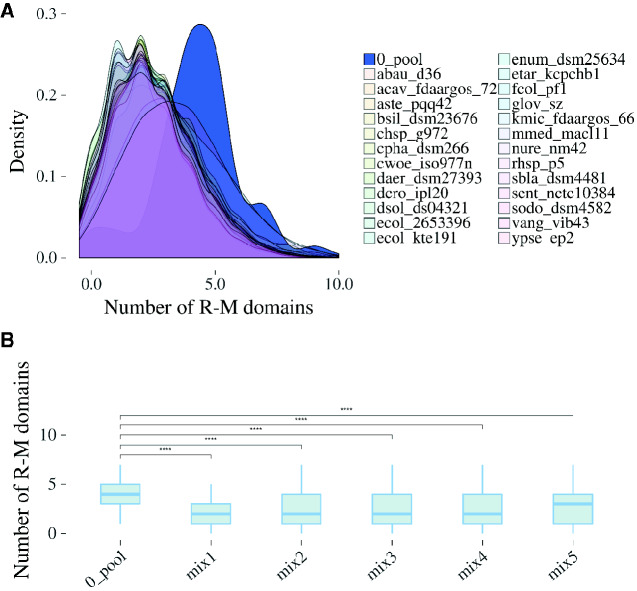
Distribution of R–M-related domains encoded in RR-like gene neighborhoods. (A) The density plot compares the distribution of genes encoding R–M domains found in close proximity to RR-like genes between the data set representing 628 actual bacterial genomes (0_pool) and the respective 2000 shuffled versions (pseudogenomes) of 25 different genomes gleaned from the 0_pool. Species and strain names are abbreviated as follows: Acinetobacter baumannii (abau_d36), Aeromonas caviae (acav_fdaargos_72), Alteromonas stellipolaris (aste_pqq42), Brevibacterium siliguriense (bsil_dsm23676), Chryseobacterium sp. G972 (chsp_g972), Chlorobium phaeobacteroides (cpha_dsm266), Conexibacter woesei (cwoe_iso977n), Diaminobutyricimonas aerilata (daer_dsm27393), Devosia crocina (dcro_ipl20), Dickeya solani (dsol_ds04321), Escherichia coli (ecol_2653396), Escherichia coli KTE191 (ecol_kte191), Endozoicomonas numazuensis (enum_dsm25634), Edwardsiella tarda (etar_kcpchb1), Flavobacterium columnare (fcol_pf1), Geobacter lovleyi (glov_sz), Klebsiella michiganensis (kmic_fdaargos_66), Martelella mediterranea (mmed_macl11), Nitrosomonas ureae (nure_nm42), Rhodovulum sp. P5 (rhsp_p5), Shimwellia blattae (sbla_dsm4481), Salmonella enterica subsp. enterica serovar Senftenberg (sent_nctc10384), Serratia odorifera (sodo_dsm4582), Vibrio anguillarum (vang_vib43), Yersinia pseudotuberculosis (ypse_ep2). (B) The box plots depict the statistical analysis using one-tailed Student’s t-test between the 0_pool and five compilations (“mix”) of the 25 pseudogenomes previously simulated. Each mix contains five strains. t-Test results are represented as follows: ns (P > 0.05), * (P ≤ 0.05), ** (P ≤ 0.01), *** (P ≤ 0.001), **** (P ≤ 0.0001). The mix data sets include the following above mentioned genomes: mix1—abau_d36, acav_fdaargos, aste_pqq42, bsil_dsm23676, chsp_g972; mix2—cwoe_iso977n, dear_dsm27393, dcro_ipl20, dsol_ds04321, ecol_2653396; mix3—ecol_kte191, enum_dsm25634, etar_kcpchb1, fcol_pf1, glov_sz; mix4—kmic_fdaargos, mmed_macl11, nure_nm42, rhsp_p5, sbla_dsm4481; mix5—cpha_dsm266, sent_nctc10384, sodo_dsm4582, vang_vib43, ypse_ep2.